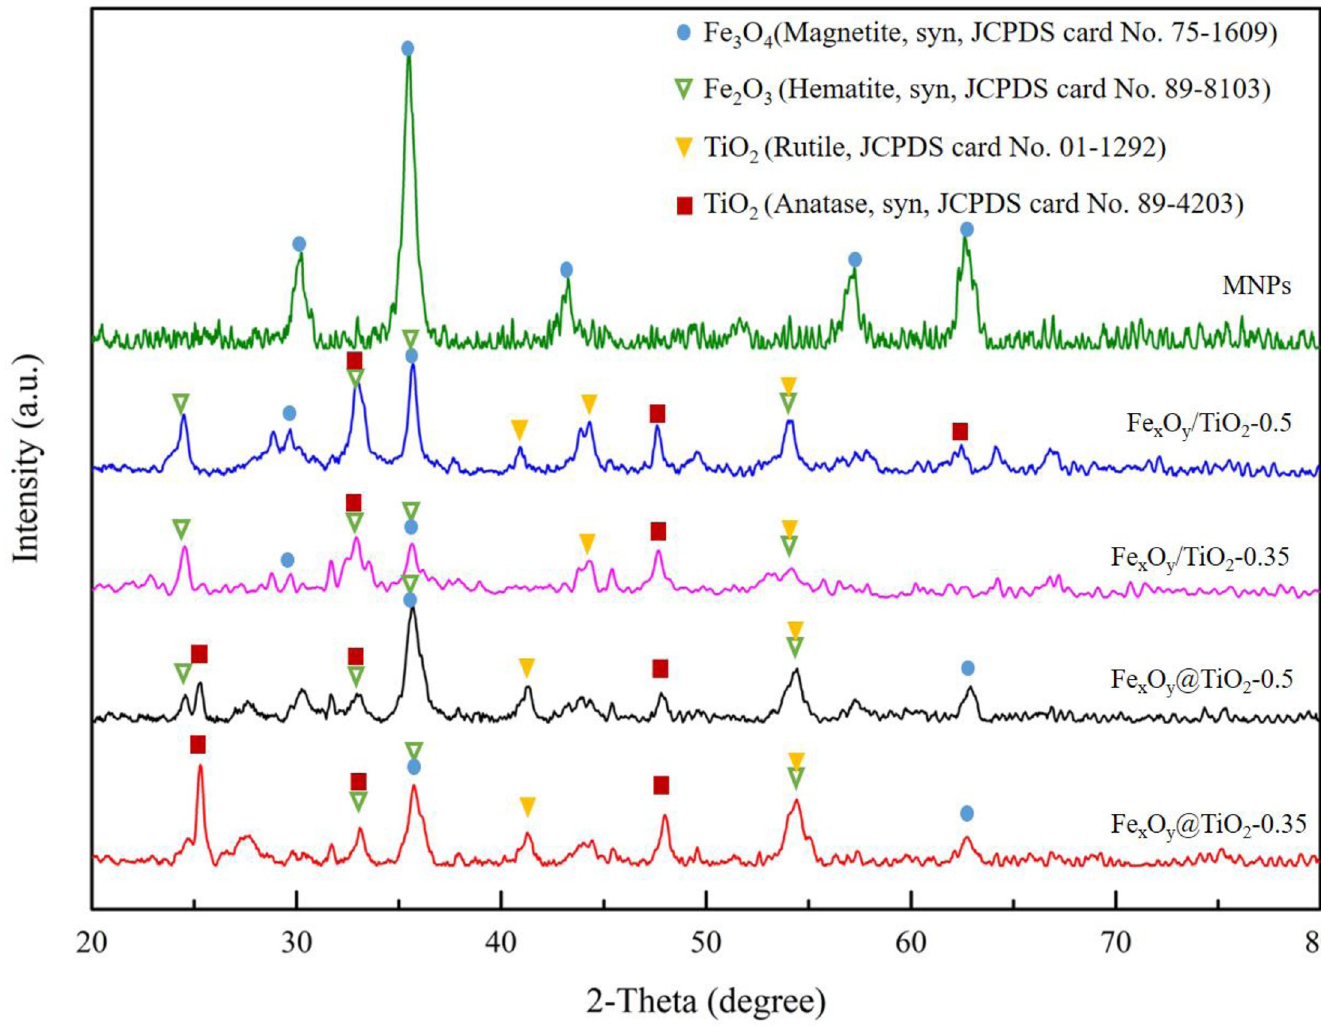
Fig 1. XRD patterns of MNPs and magnetic-TiO 2 -nanocomposites. Characteristic peaks of magnetite, hematite, rutile TiO 2 and anatase TiO 2 are marked with blue circle, green triangle, yellow triangle and red square, respectively.